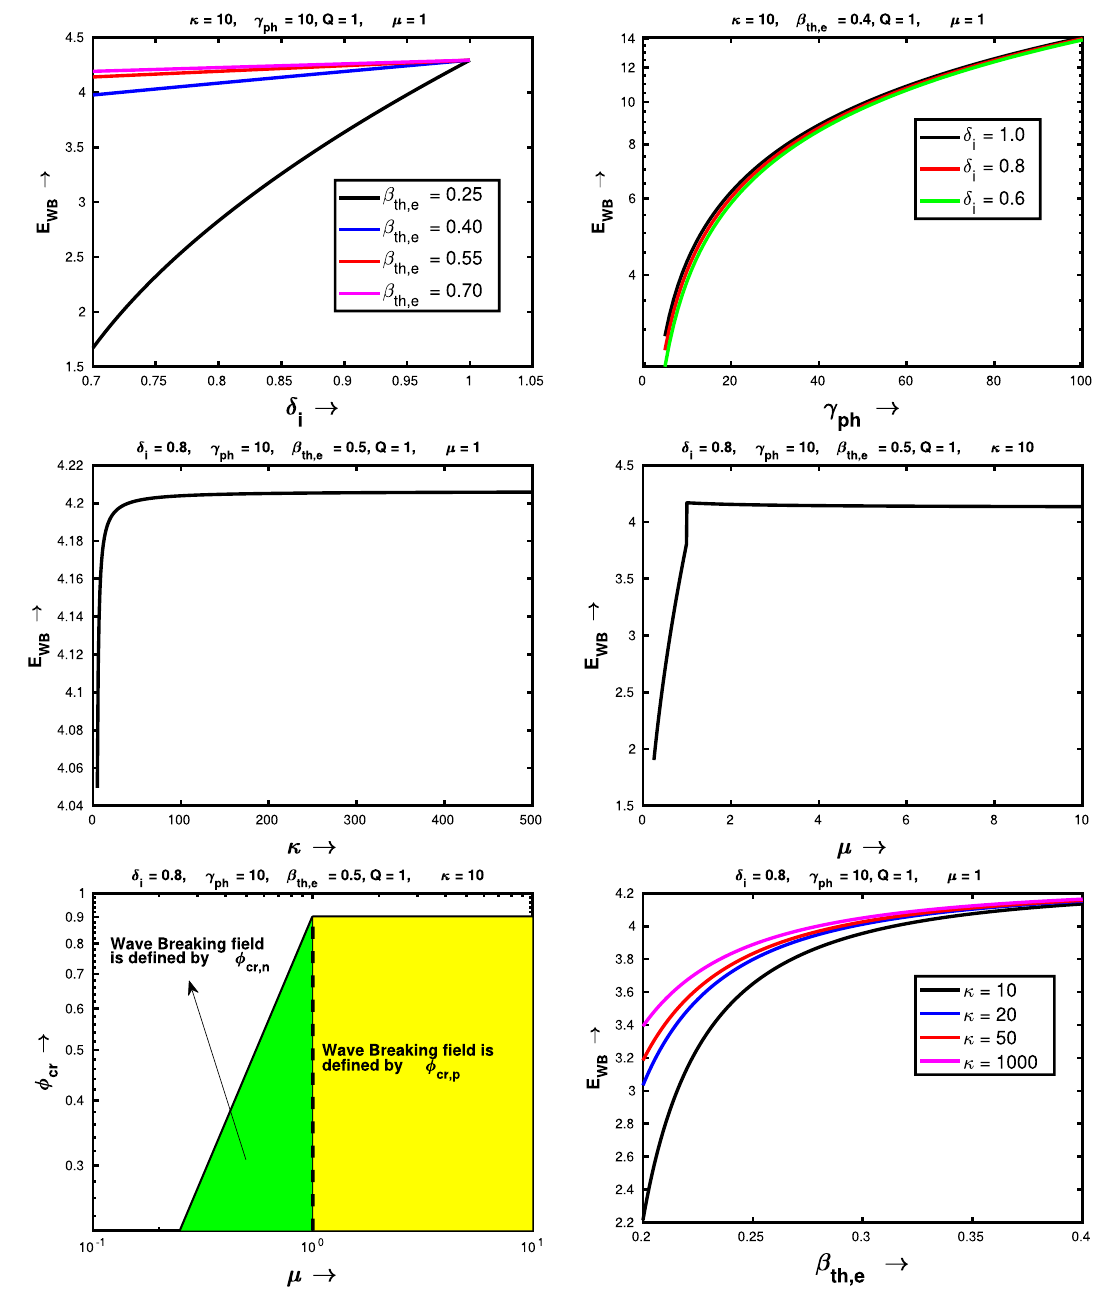
Figure 6. The variation of wave breaking amplitude with the negative-to-positive ion density ratio δ i (top left), Lorentz factor γ ph (top right), spectral index κ (middle left) and negative-to-positive ion mass ratio µ (middle right). Variation of critical value of φ as a function of µ (bottom left) and variation of wave breaking amplitude with the normalised electron thermal energy β th , e (bottom